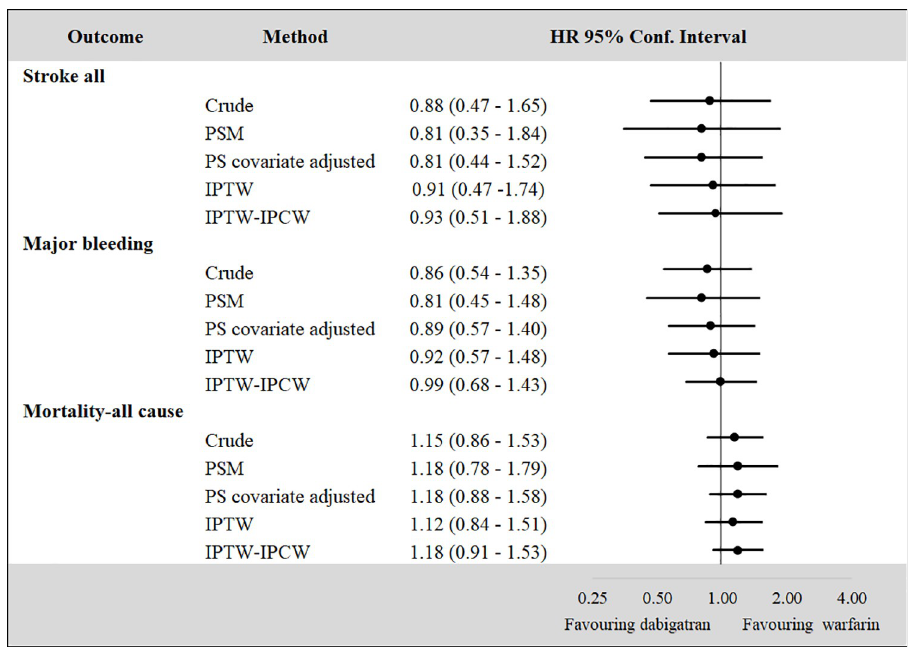
Fig 5. HRs for dabigatran vs. warfarin by propensity score methods. Note: PS = Propensity Score, PSM = Propensity Score Matching, IPTW = Inverse Probability of Treatment Weighting (IPTW), Inverse Probability of Censoring Weighting